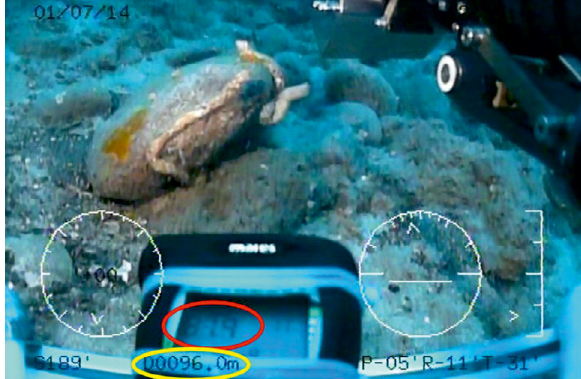
Figure 6. Picture extrapolated from a ROV video highlighting the technical issue of the pressure sensor during the ROV survey in- ferred by the difference between the depth values displayed on the video console (yellow oval) and on the depth gauge appositely ap- plied on the ROV chassis (red